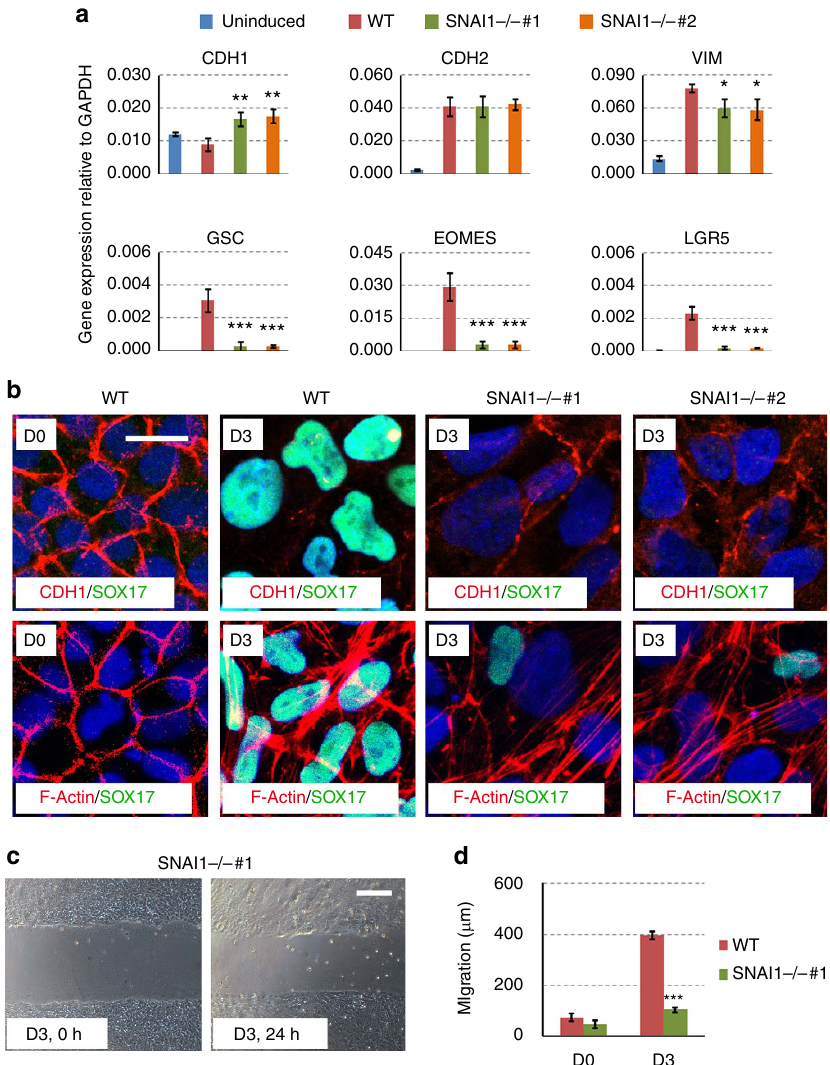
Figure 6 | SNAI1 mediates Activin A-induced EMT and DE formation. ( a ) qRT-PCR analysis of EMTand lineage genes in WTand SNAI1 knockout lines. Data represent mean ± s.d. from three biological repeats. Significance between WTand mutants were determined by Student’s unpaired t -test (* P o 0.05; ** P o 0.01; *** P o 0.001). ( b ) Immunofluorescence staining of WTand SNAI1 knockout hESCs at D3. Scale bar, 20 m m. ( c , d ) Migration assays for WTand SNAI1 knockout lines at D3. Scale bar, 100 m m. Significance between WT and mutant was determined by Student’s unpaired t -test (data represent mean ± s.d. from three technical repeats,*** P o